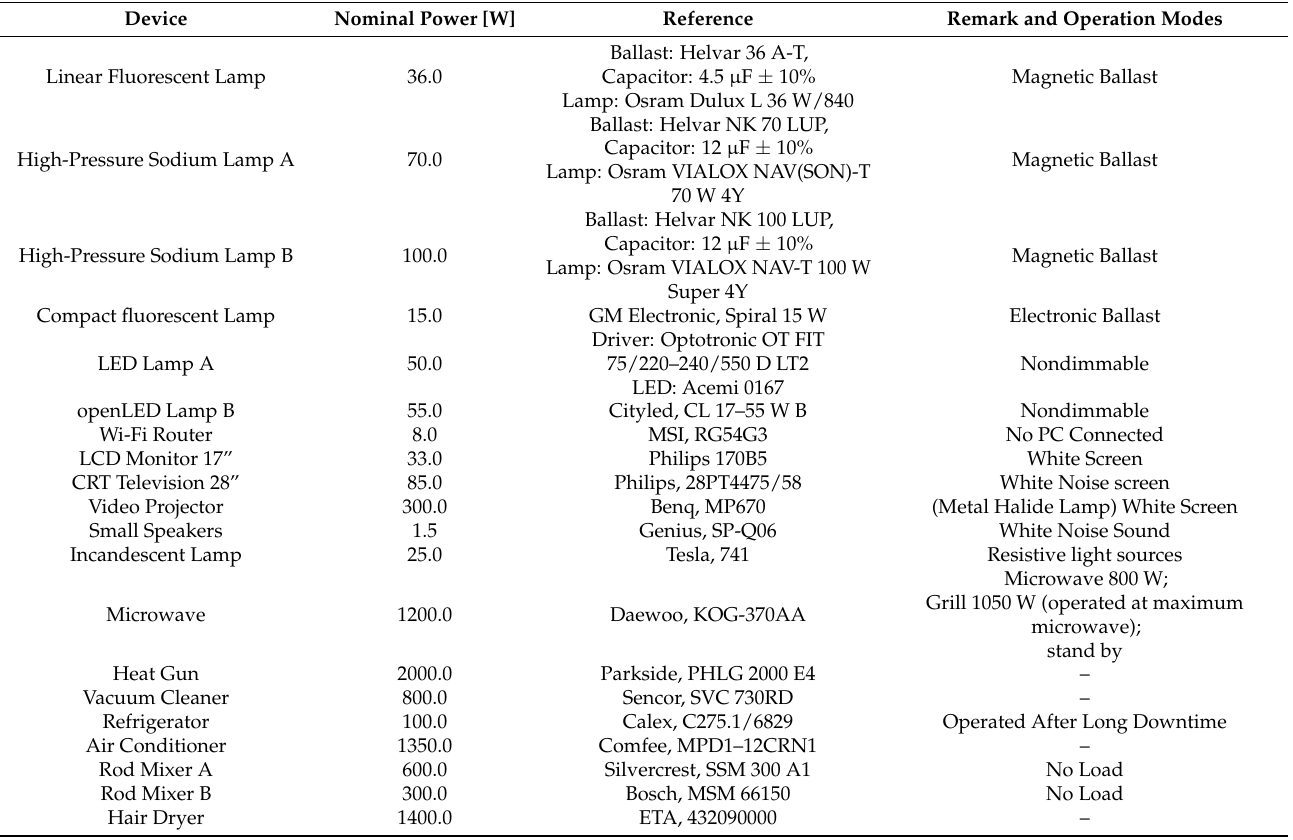
Table 1. List of measured single-phase home